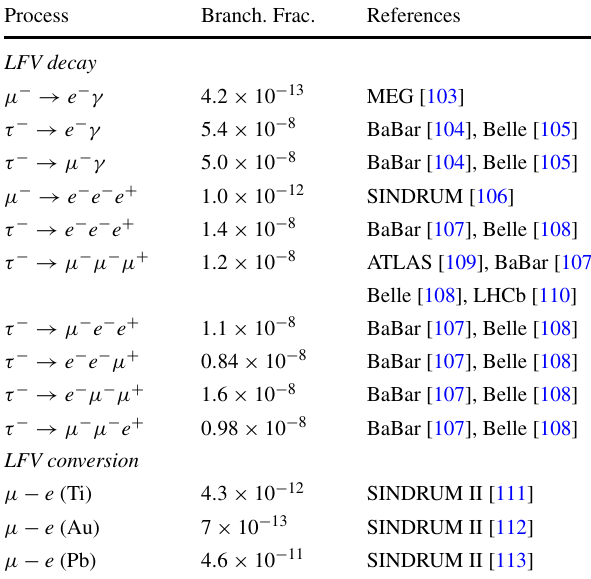
Table 2 Experimental upper bounds on LFV processes, along with the experiments that provided that bound. When more than one experiment is cited, the HFLAV average is used [34]. All upper bounds are given at the 90% CL Process Branch.